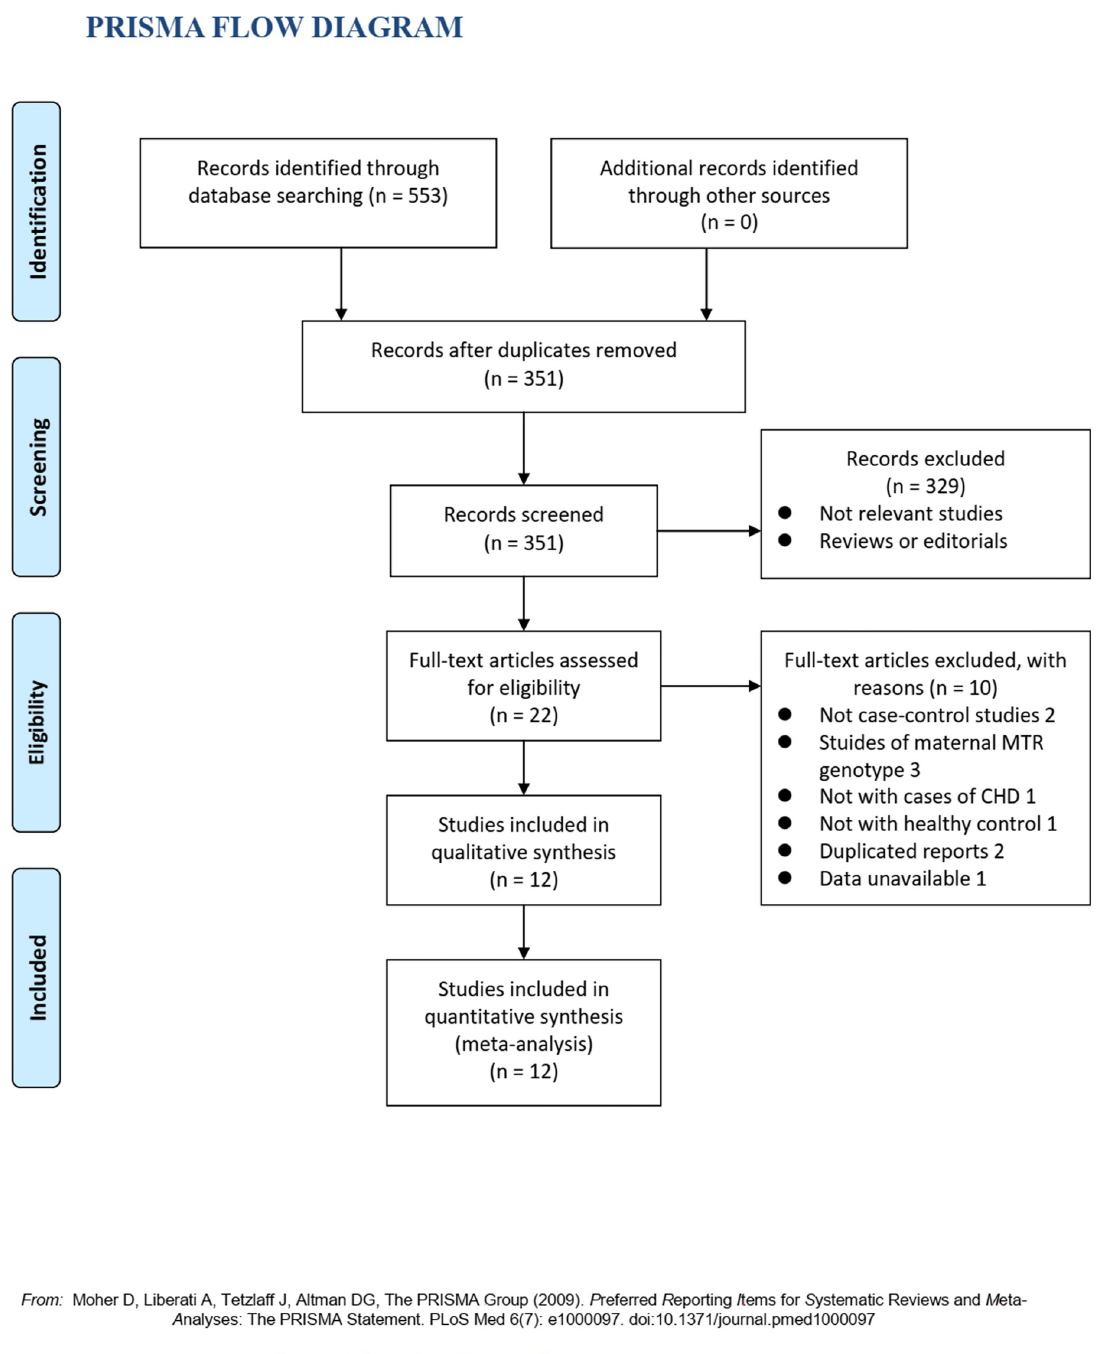
Fig 1. Flowchart of the database search and study